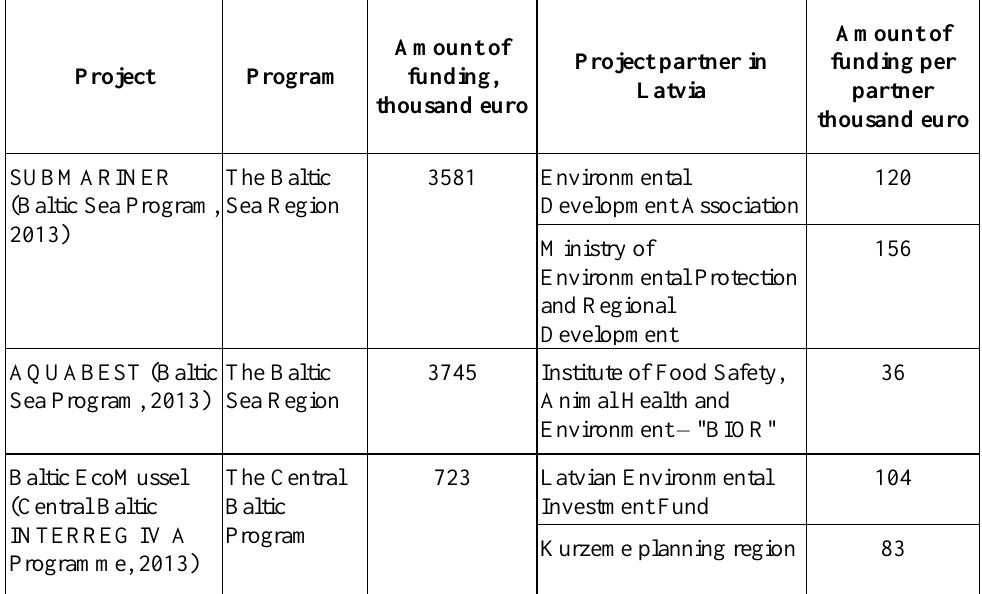
Table 1. Research Projects on Mussel Farming in Latvia until 2015